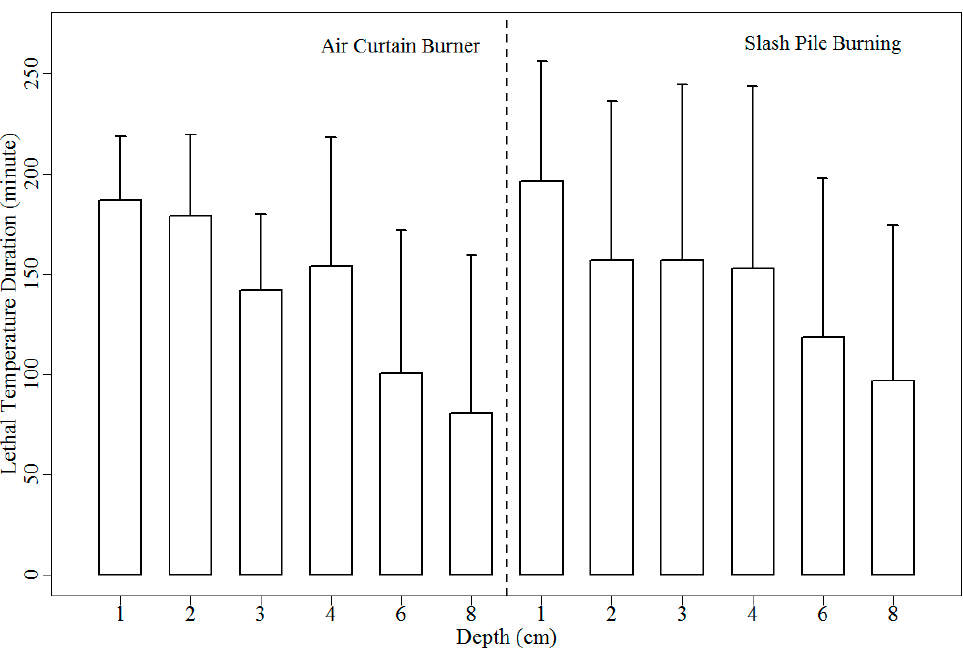
Figure 3. Mean lethal temperature duration by soil depth. Error bars represent one standard deviation.